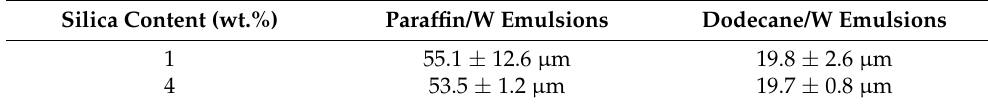
Table 2. Average droplet diameter of direct Paraffin/Water and Dodecane/Water emulsions. Silica Content